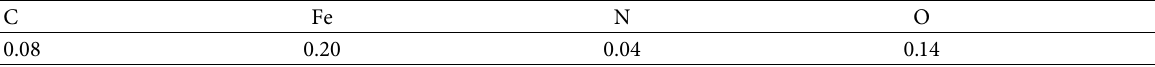
Table 1: Chemical composition (wt. %) of the experimental titanium